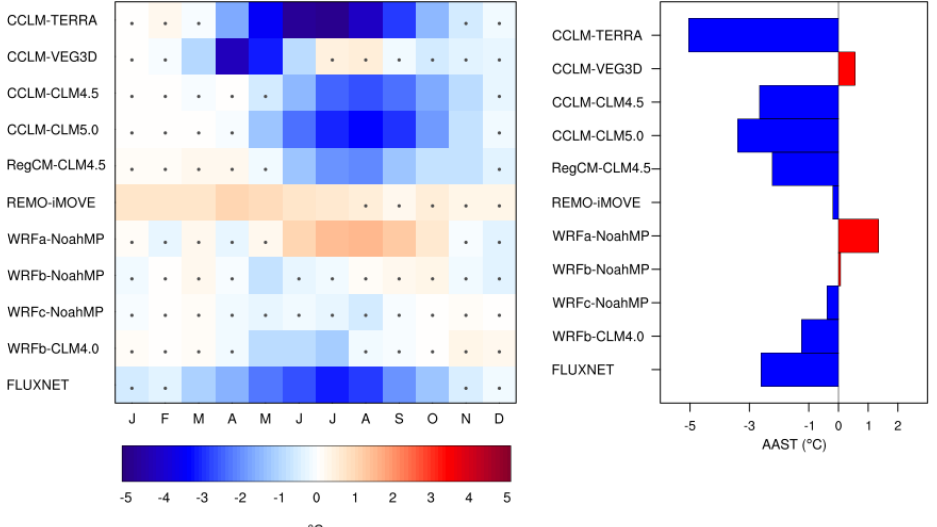
Figure 11. Left: observed and simulated impact of afforestation on mean monthly soil temperature. The dots indicate the differences which are insignificantly different from zero in a two-sided t test at 95% confidence level. Right: the changes in AAST ( ◦ C) due to afforestation across models and observations. The observational differences are averaged over all the paired FLUXNET sites (forest minus open land) and the simulated changes are averaged over the corresponding model grids (FOREST minus GRASS). Positive (negative) values indicate an increase (decrease) with